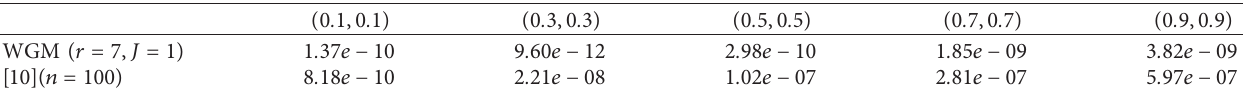
Table 6: Comparison of maximum absolute value errors with the proposed method in [10] for Example 3.